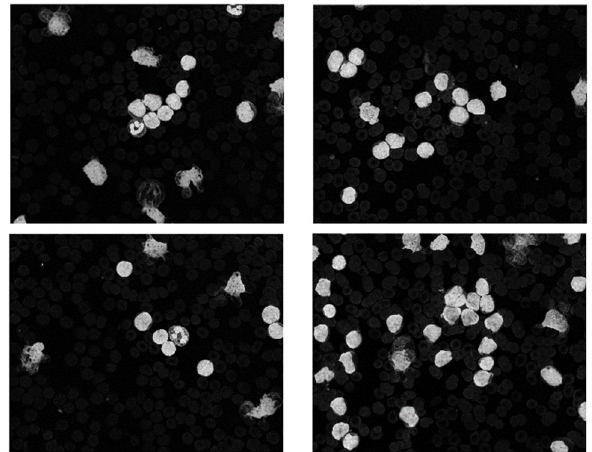
Figure 4. Saturation component.